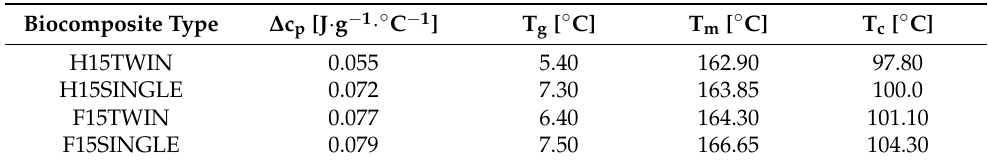
Table 7. Composite weight loss as a function of temperature for PHBV biocomposites with 15 wt.% share of hemp and flax fibers using different extrusion methods.